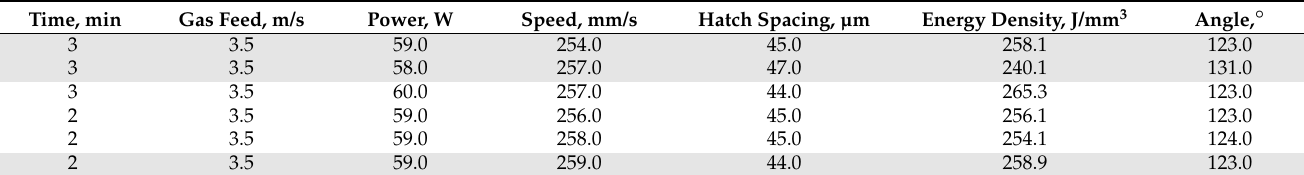
Table 4. Process parameters suggested by the DGEMO algorithm. Highlighted rows indicate the Pareto set.